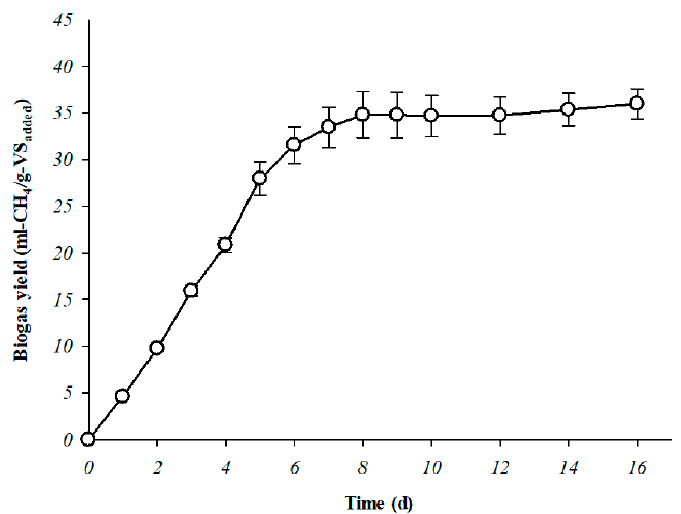
Figure 5. Cumulative methane production in batch type anaerobic digestion of the solid remaining SCG extracted using organosolv treatment. Table 5. Chemical compositions of the solid fraction residues of SCG and theoretical biochemical methane potential (BMP) of the solid remaining SCG extracted from organosolv treatment.